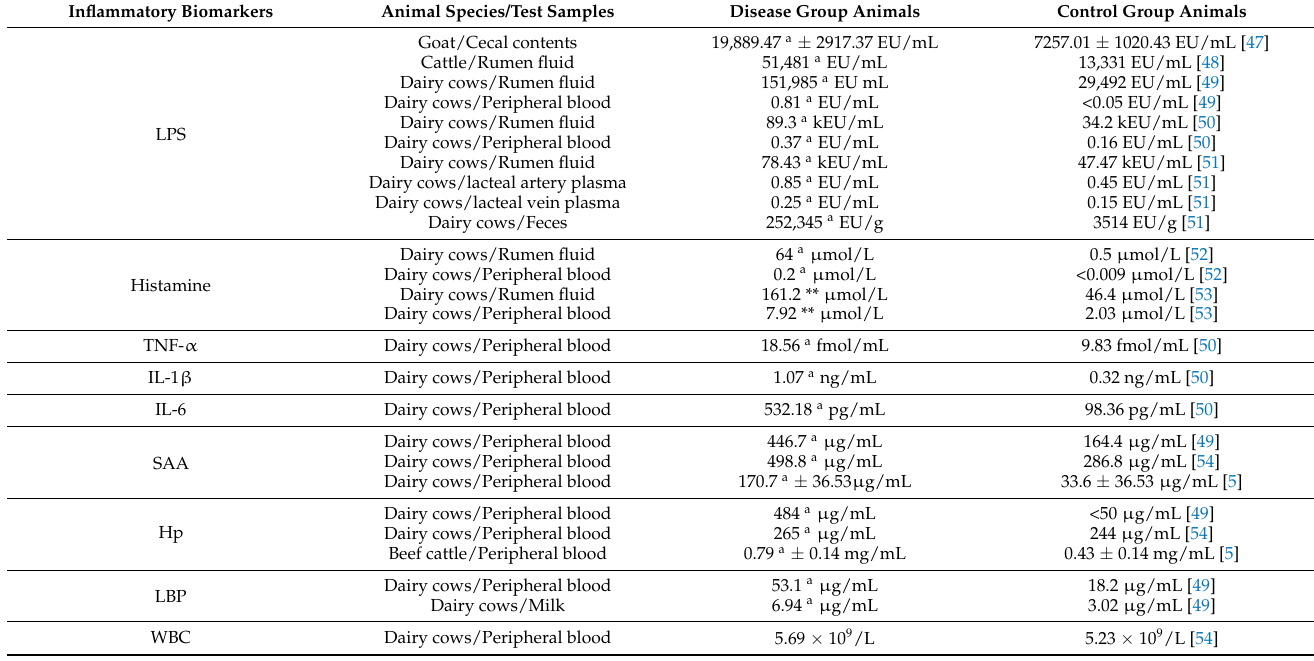
Table 1. The changes of inflammatory markers in animals with